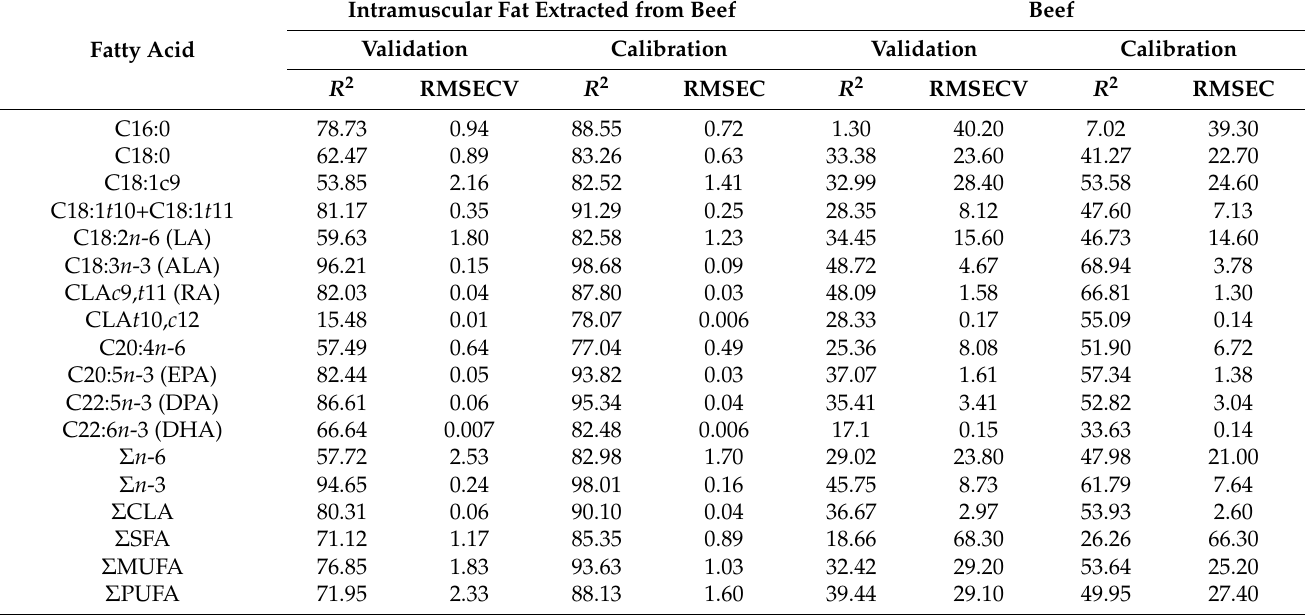
Table 2. The R 2 value informs how close the CG values and FT-MIR predictive values are. The values varied between 0.96 and 0.15 for the different FA. The main conclusion is that MIR spectroscopy can be used to predict some FA sums (i.e., ∑ n -3 PUFA, ∑ CLA, ∑ MUFA, ∑ PUFA, and ∑ SFA) but also for individual PUFA (i.e., ALA, DPA, EPA, RA, C18:1 t 10+C18:1 t 11). The determination coefficients found in this study are lower than the results obtained in pork [13,14]. Ripoche and Guillard [14] reported higher deter- mination coefficients for ∑ SFA (0.92), ∑ MUFA (0.98), and ∑ PUFA (0.98) in pork fat by FT-MIR spectroscopy. The lower validation coefficients of the present study ( ∑ SFA = 71.12; ∑ MUFA = 76.85; ∑ PUFA = 71.95), can be explained because ruminants transform FA in the rumen, and the amount and composition of fat leaving the rumen differ from intake [32]. Table 2. Optimized model of the fatty acid content of beef: coefficients of determination ( R 2 ) and root mean square error for cross-validation (RMSECV) and for calibration